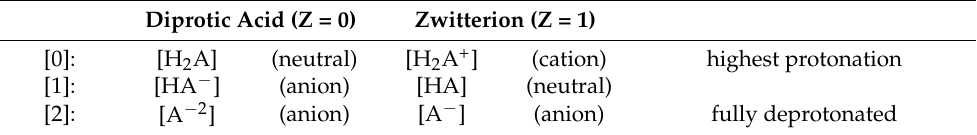
Table 10. The three species of an ordinary diprotic acid vs. the simplest zwitterion.